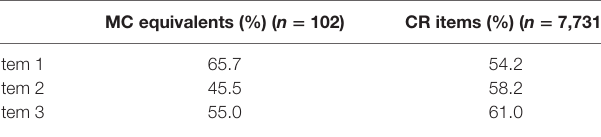
Table 5 | Mean score for multiple-choice (MC)-equivalent items and the national constructed-response (CR) items. Mc equivalents (%) ( n =